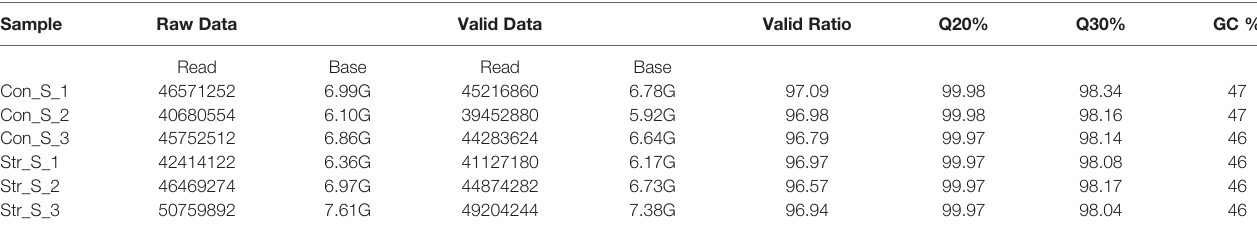
TABLE 2 | Overview of reads for mRNA-seq and quality fi ltering.